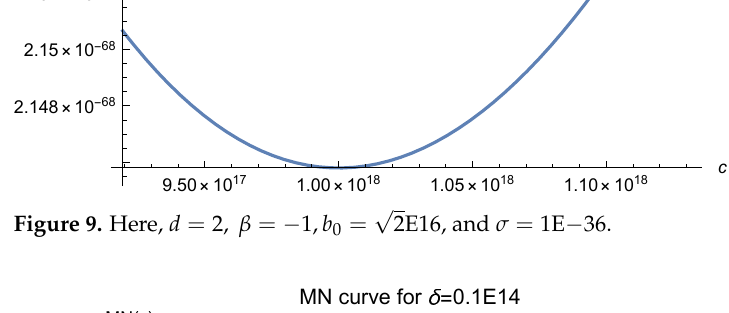
Figure 9. Here, d = 2, β = − 1, b 0 =